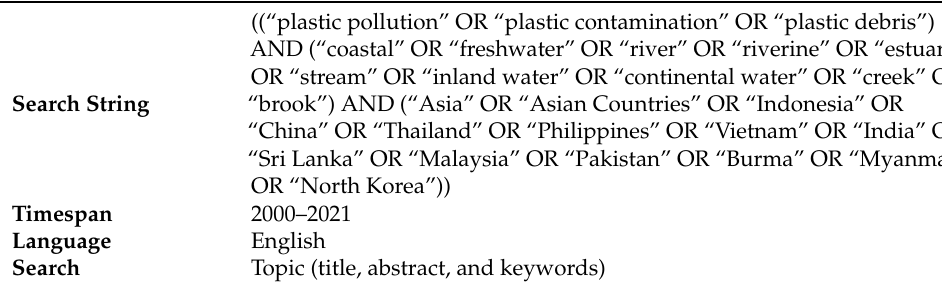
Table 2. Search string and selection